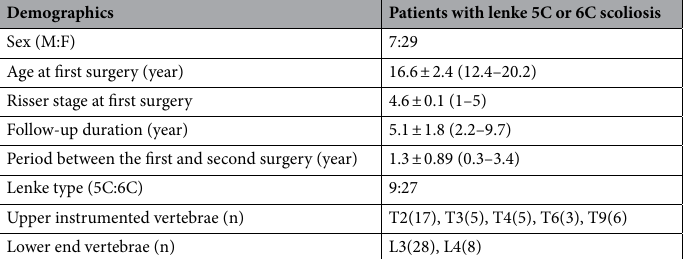
Before the second surgery At the last